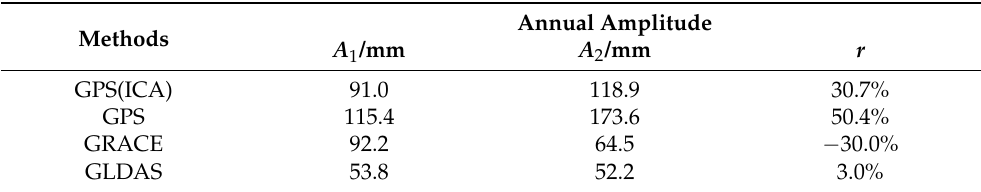
Table 1. Comparisons between the estimated TWS variations in northwestern Sichuan-Yunnan and the entire region for the different methods.